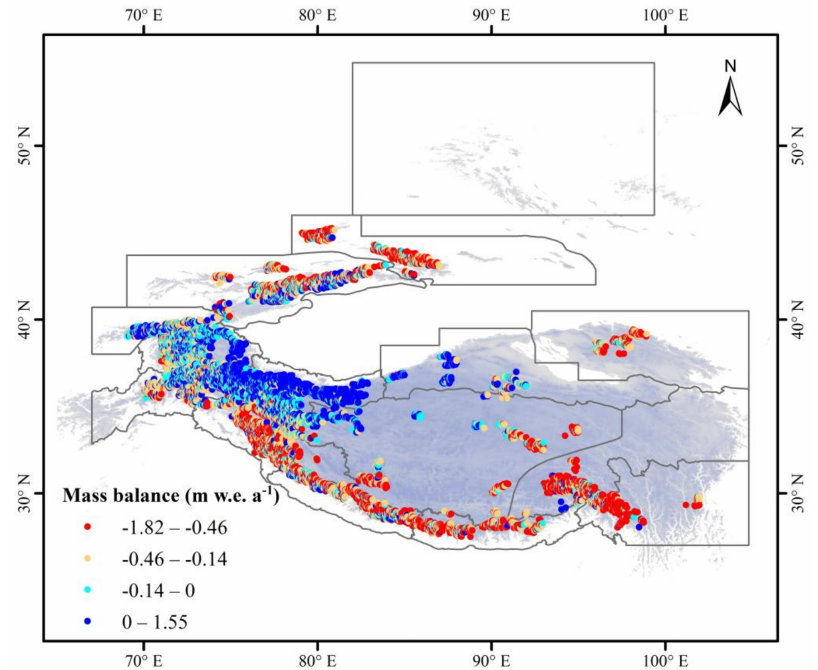
Figure 11. Spatial distribution of the mass balance was significantly correlated with topographic shading during